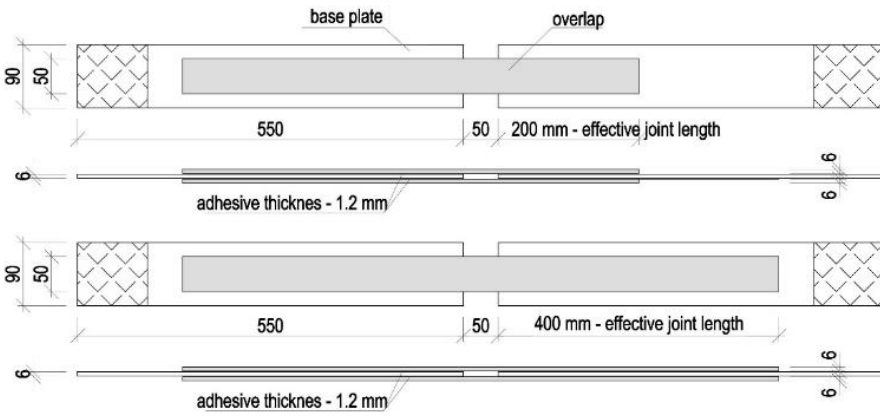
Figure 7. Geometry of the full-size adhesively bonded joints (DLJ).